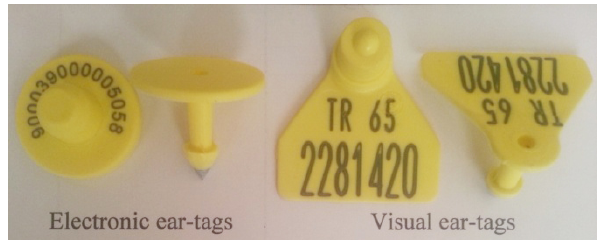
Figure 1. Electronic and visual ear tags used for the identification of